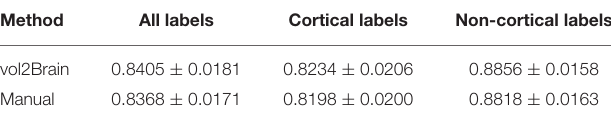
TABLE 5 | Proposed method dice results.